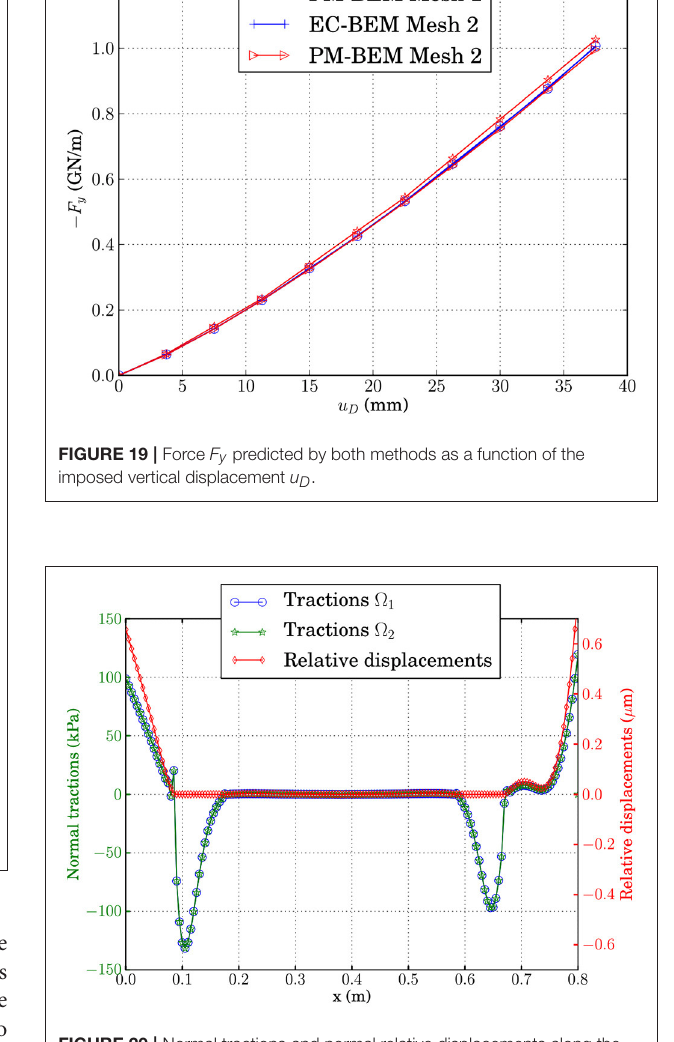
FIGURE 20 | Normal tractions and normal relative displacements along the potential contact zone in the example of Figure 9 with the adhesive elastic contact computed by EC-BEM, and with u D = 0.035